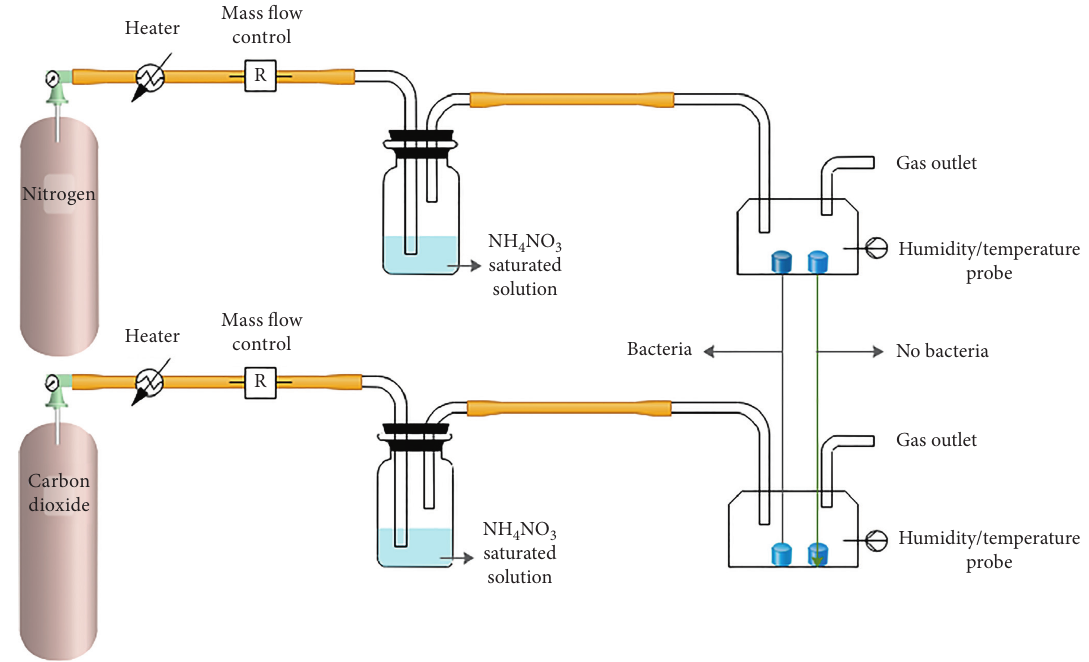
Figure 4: Schematic diagram of mineralization/carbonization setup.